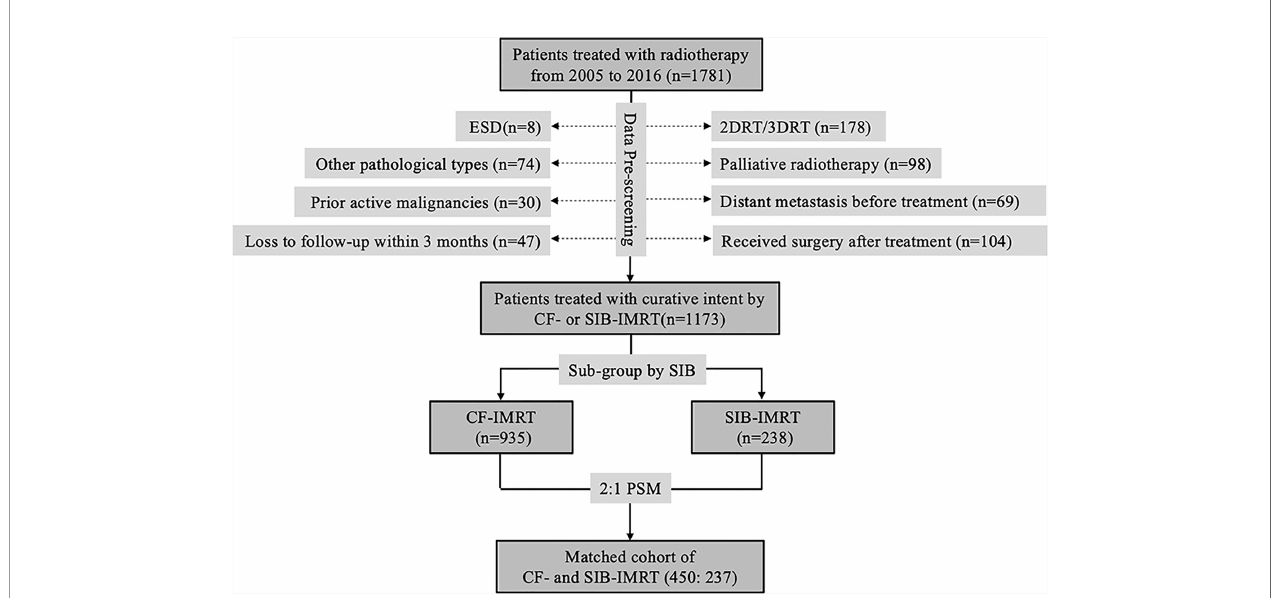
FIGURE 1 | CONSORT diagram showing patient selection. ESD, endoscopic submucosal dissection; 2DRT, two-dimensional radiotherapy; 3DRT, three- dimensional radiotherapy; IMRT, intensity-modulated radiotherapy; CF-IMRT, conventional fractionation IMRT; SIB-IMRT, simultaneous integrated boost-IMRT; PSM, propensity score